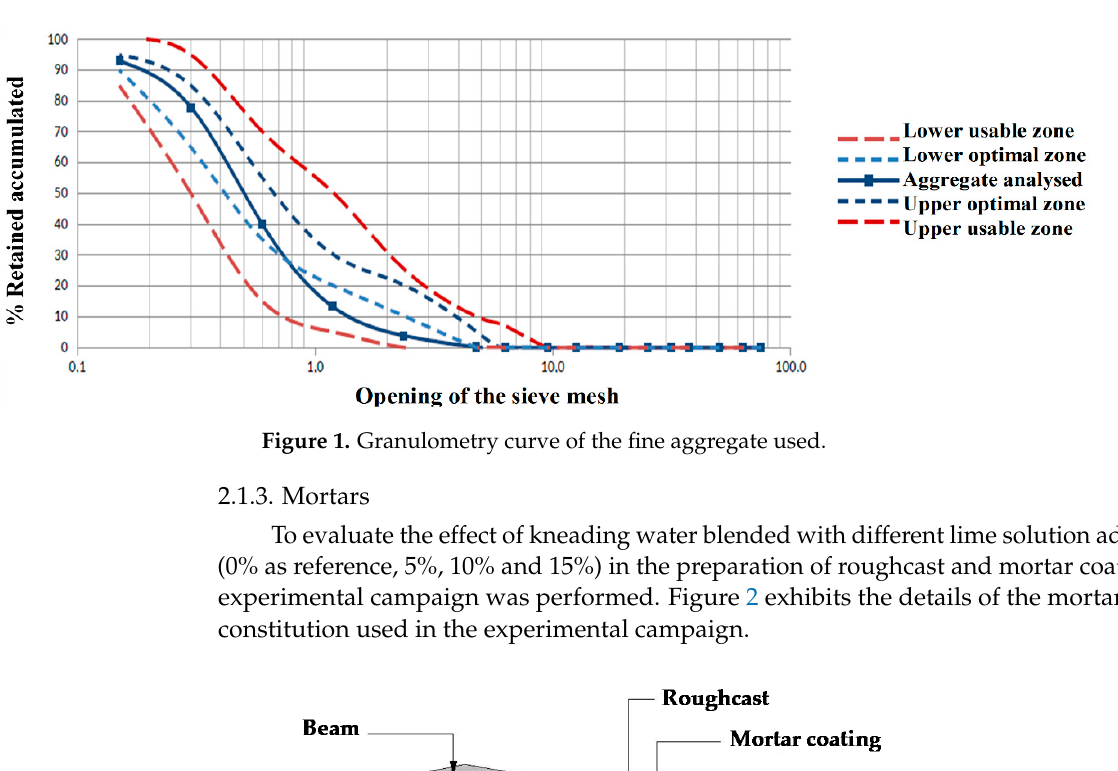
Table 3. Fine aggregate description.